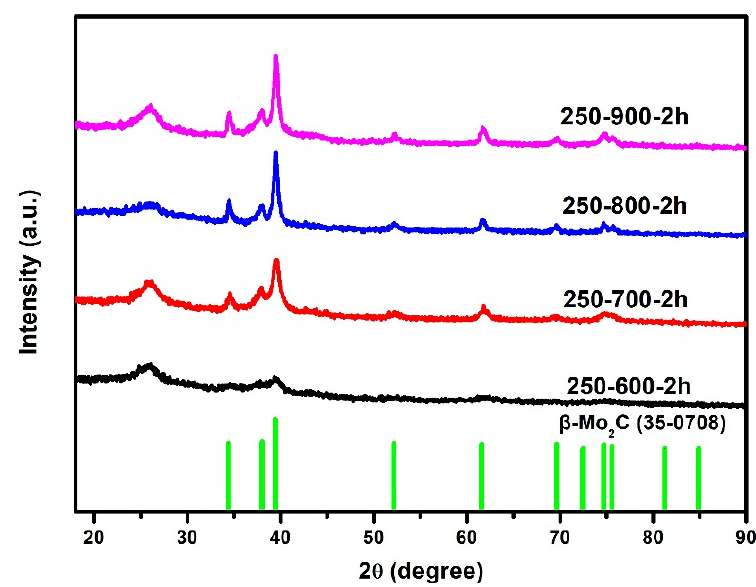
Figure 1. XRD patterns of catalysts with different calcination temperatures.